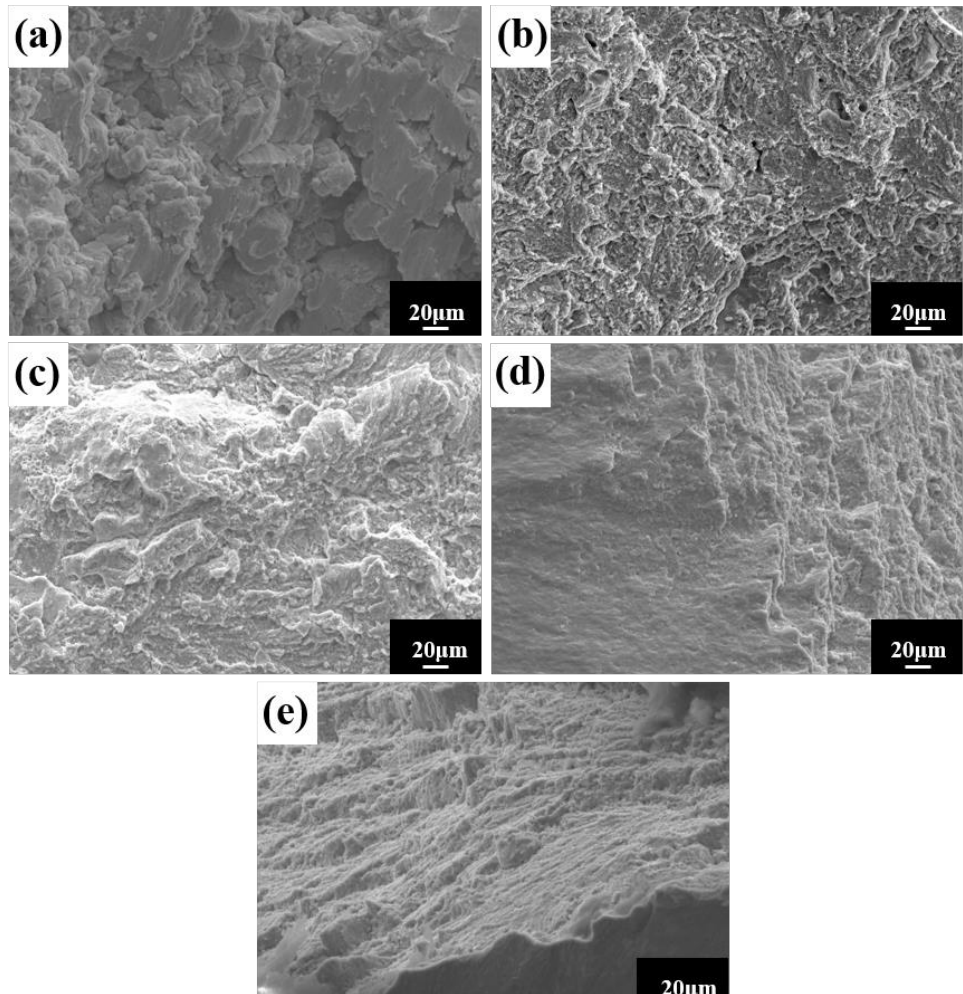
Figure 15. Compression fracture morphology of HEA at different sintering temperatures: ( a ) 950 °C; ( b ) 1000 °C; ( c ) 1050 °C; ( d ) 1100 °C; and ( e ) 1150 °C.